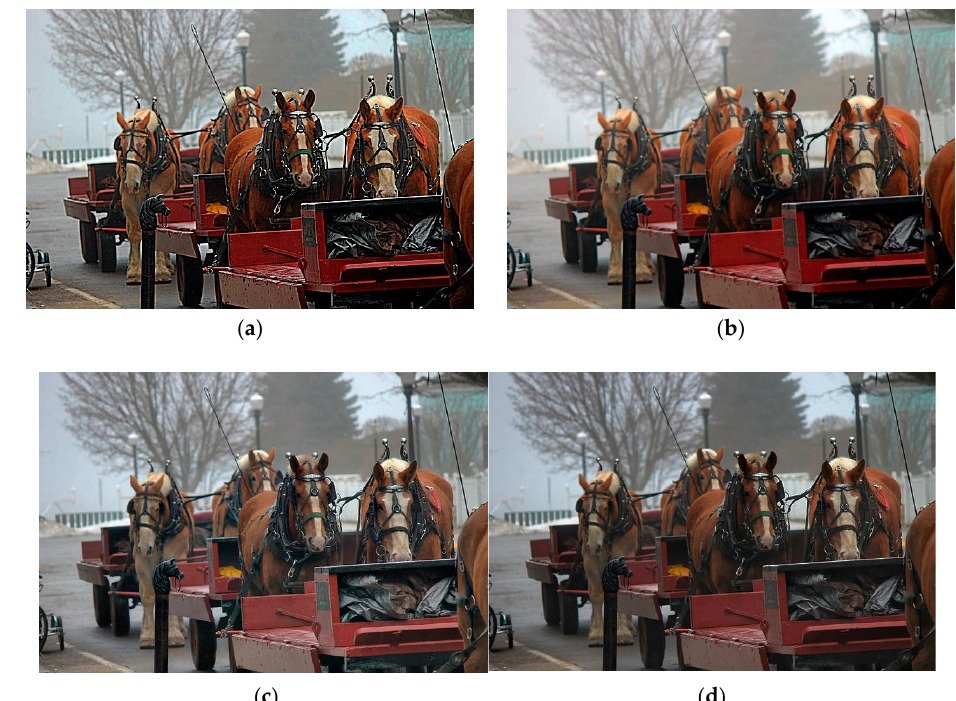
Figure 8. ( a ) PA, ( b ) with high-boost filter setting, ( c ) AMEF ( c = 0.03), and ( d ) AMEF without CLAHE.